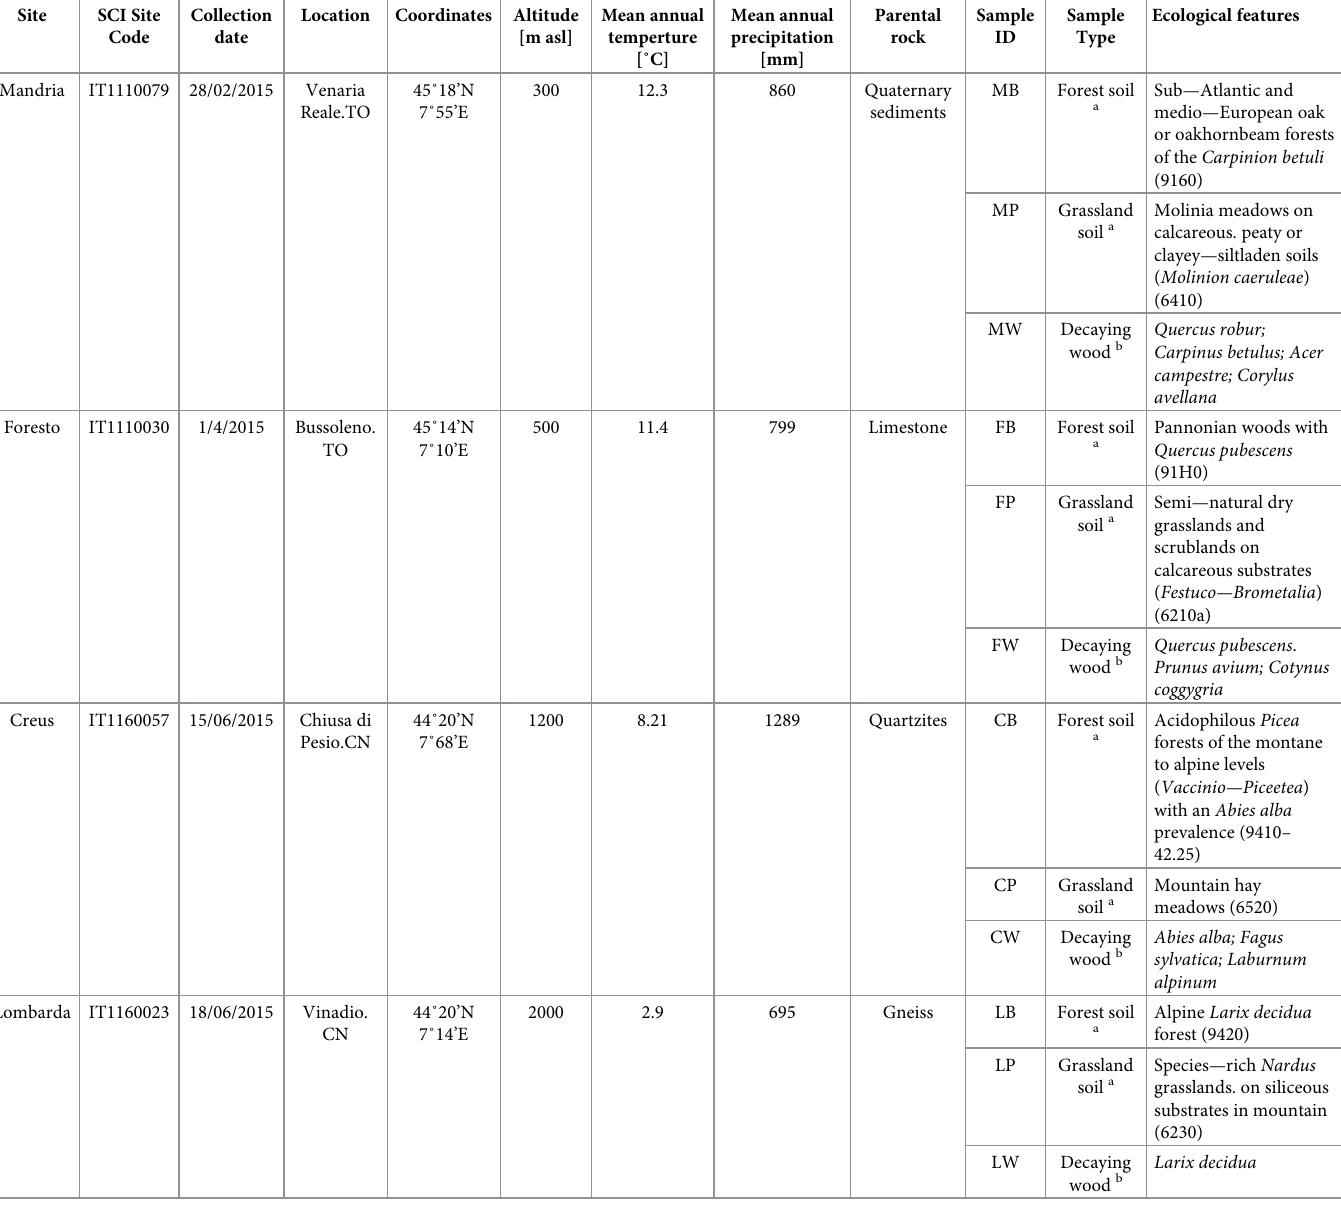
Table 1. Origin and characteristics of the soil and wood samples.